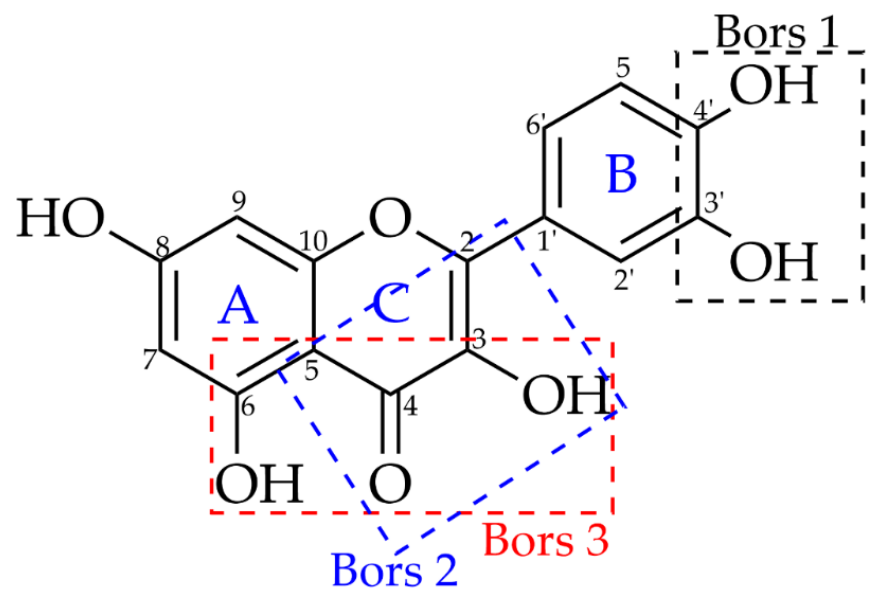
Figure 10. Bors Criteria to describe flavonoid activity (adapted from Platzer et al. [65]). The first criterion is the presence of a catechol group on Ring B (Bors 1), which increases the stability of the resulting antioxidant radical. The second is the presence of a 2,3 double bond combined with a 4-oxo group on Ring C (Bors 2), which facilitates electron delocalization. The third is the presence of OH groups at positions 3 and 5 in combination with a 4-oxo group, which enables electron delocalization via hydrogen bonds